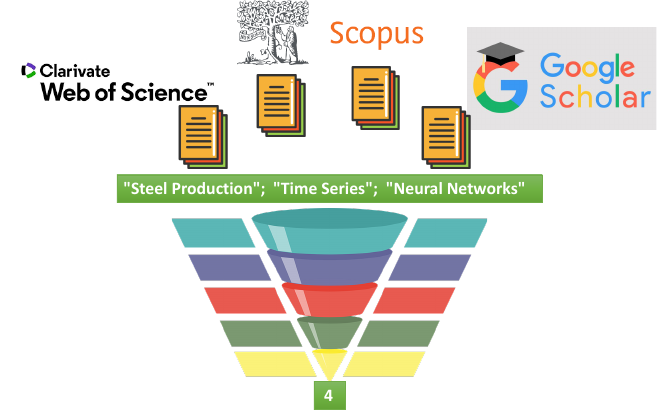
Figure 1. Results of the searches in the scientific articles